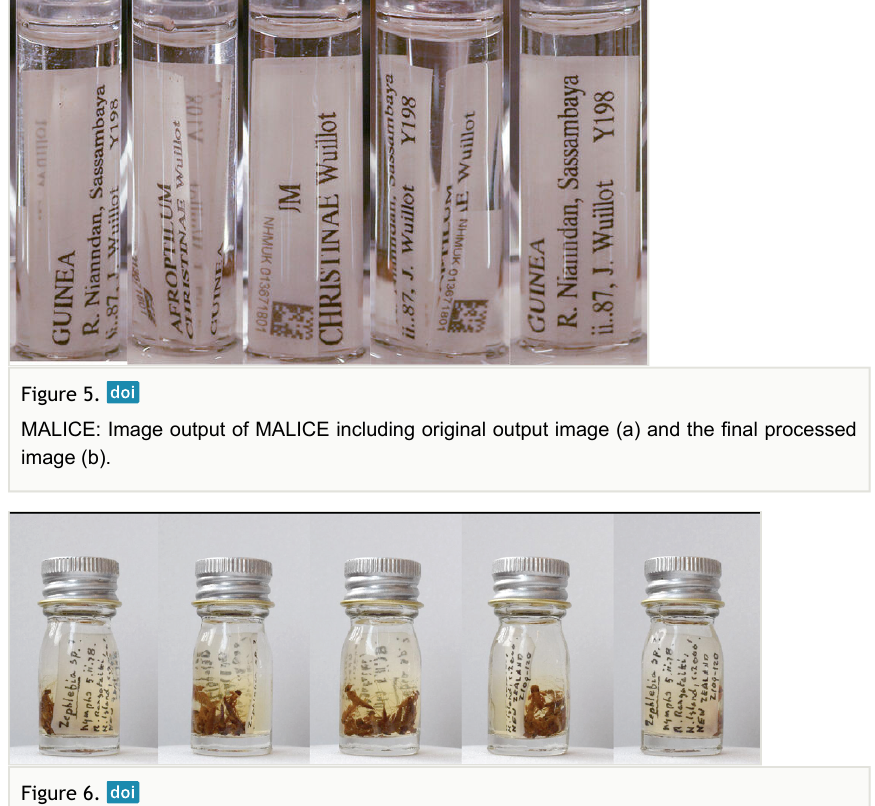
Figure 6. VILE: Image output of VILE after cropping and stitching five individual images